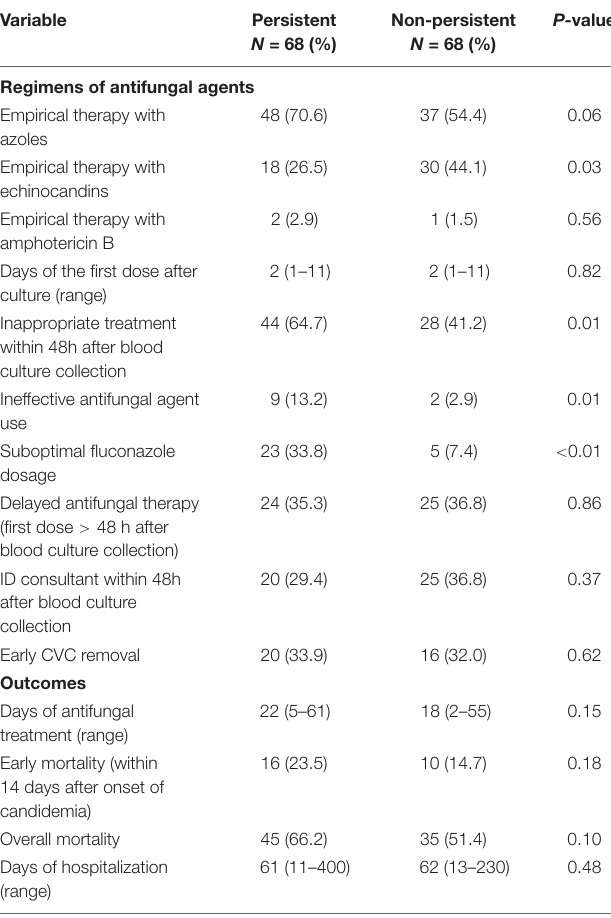
TABLE 2 | Treatment regimens and outcomes of the 136 adult patients with persistent and non-persistent candidemia after propensity-score matching.